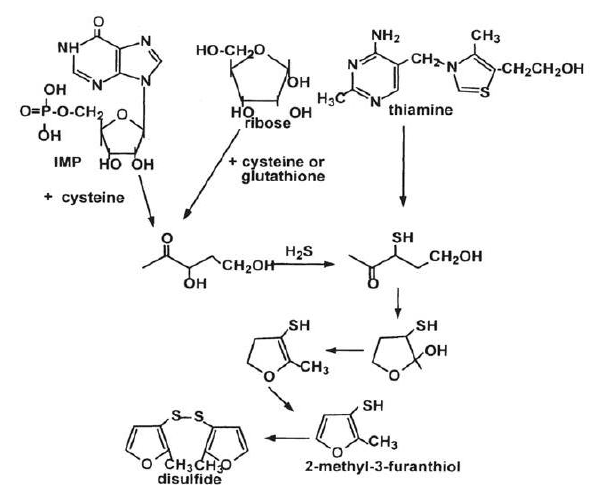
Figure 2. Mechanism for formation of 2-methyl-3-furanthiol and its disulfide by interaction of pentose sugars with cysteine or glutathione or by degradation of thiamine (Melton,